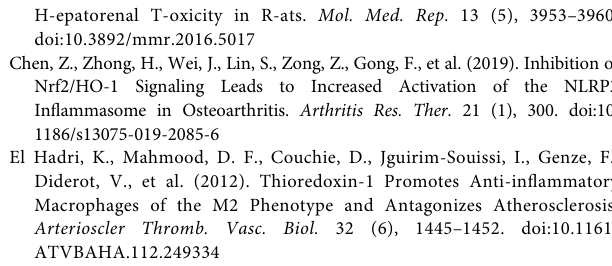
Frontiers in Pharmacology |